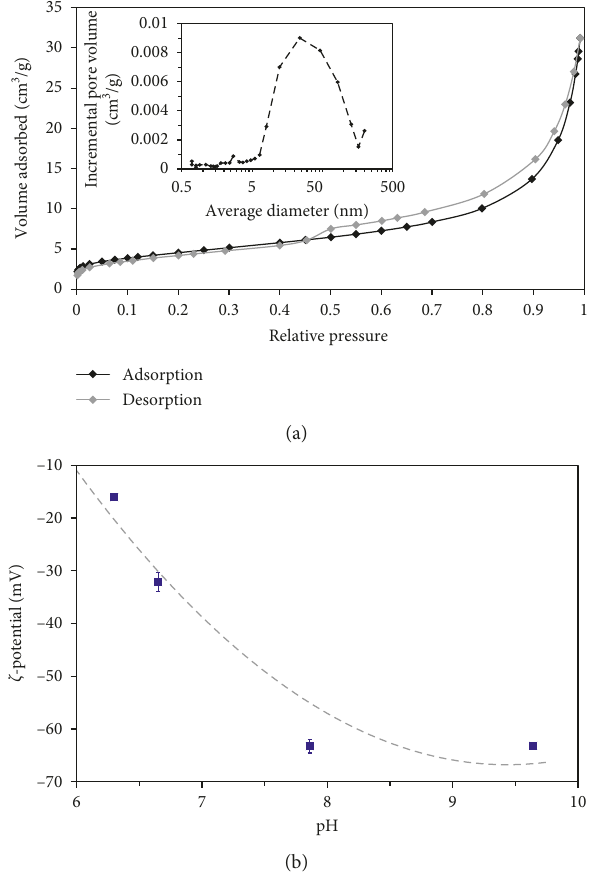
Figure 2: (a) Nitrogen adsorption/desorption isotherm and pore size distribution and (b) Zeta potential of Al-waste-NaP1.